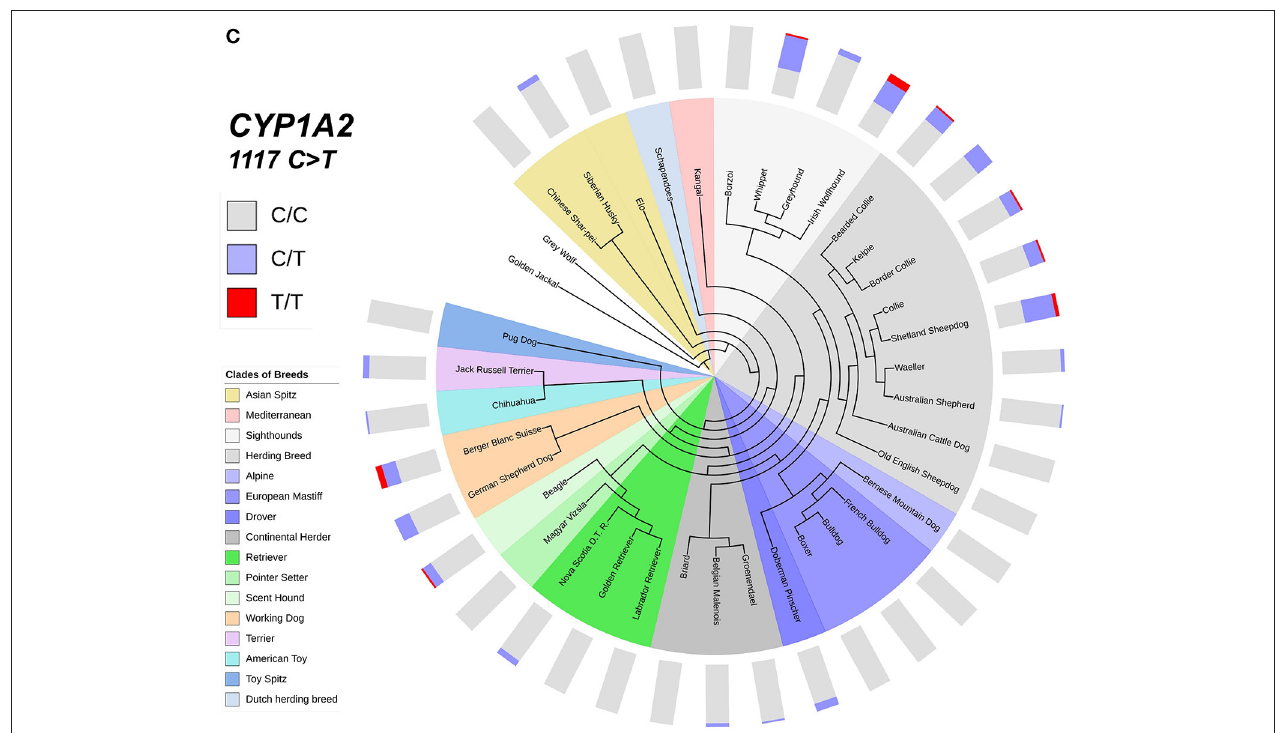
FIGURE 4 | Comparative genotyping for CYP2C41, MDR1, and CYP1A2. All subjects listed in Table 5 were genotyped for CYP2C41 (A) , and also for the occurrence of the nt230(del4) MDR1 mutation (B) , and the CYP1A2 1117C > T single nucleotide polymorphism (C) . Charting of phylogenetic relationships and rooting of the 36 analyzed breeds was carried out according to Parker et al. ( 20). The phylogenetic tree was adapted to and displayed with the Interactive Tree Of Life (iTOL) tool (http:// itol.embl.de/). The clustering of breeds (see color code) was carried out according to Parker et al. ( 20). The breeds Schapendoes, Elo, and Groenendael were included and grouped according to their breed history. Bar charts show color-coded percentage genotype